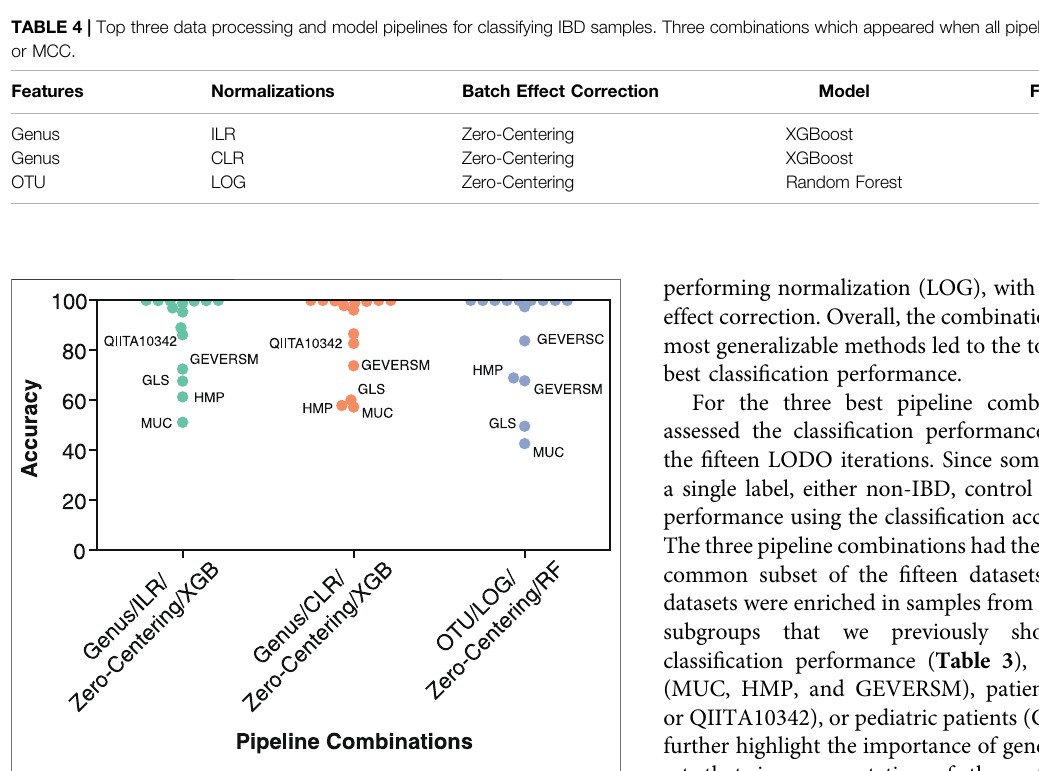
FIGURE 7 | Individual classi fi cation accuracy of the 15 datasets by the top three performing pipeline combinations. Classi fi cation accuracy was calculated individually for each of the datasets from the 15 LODO iterations. The three pipelines consist of (1) genus features, ILR transformation, Zero-Centering batch effect reduction, and a XGBoost classi fi er (Genus/ILR/ Zero-Centering/XGB), (2) genus features, CLR transformation, Zero- Centering batch effect reduction, and a XGBoost classi fi er (Genus/CLR/Zero- Centering/XGB), and (3) OTU features, LOG normalization, Zero-Centering batch effect reduction, and a Random Forest classi fi er (OTU/LOG/Zero- Centering/RF). Points corresponding to one of the fi ve datasets with the lowest classi fi cation accuracy are